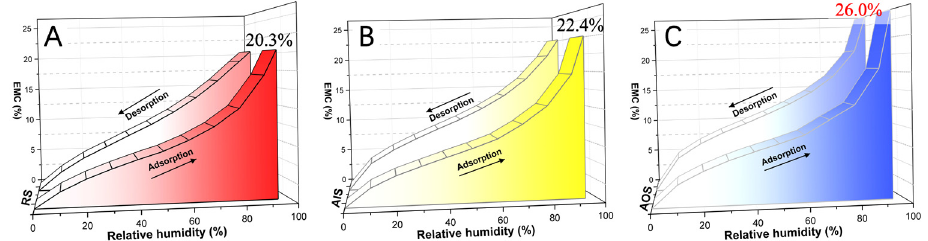
Figure 2. Multistep sorption isotherms of ( A ) the reference sample (RS), ( B ) the archaeological inner ‐ location sample (AIS), and ( C ) the archaeological outer ‐ location sample (AOS).